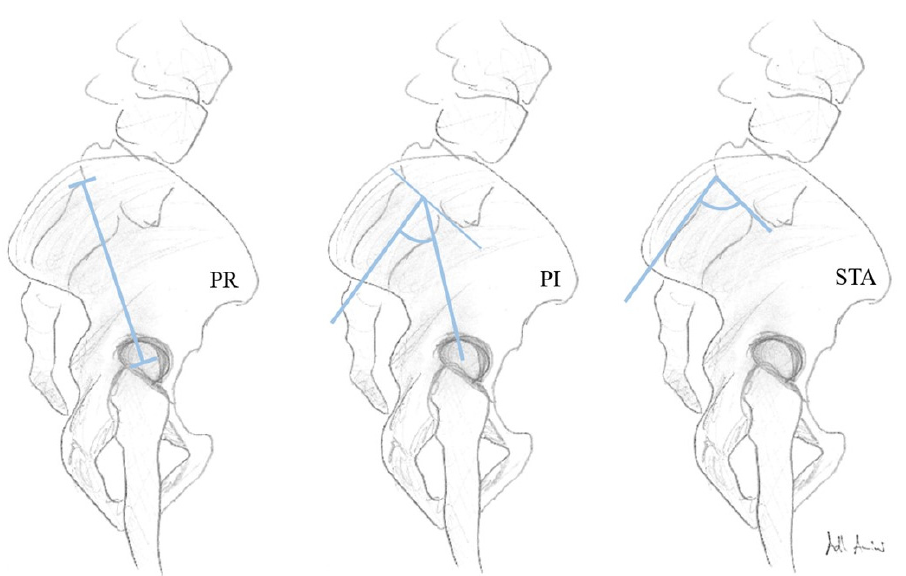
Figure 1. Schematic illustration of the constant anatomical parameters pelvic radius (PR), pelvic incidence (PI), and sacral table angle (STA).